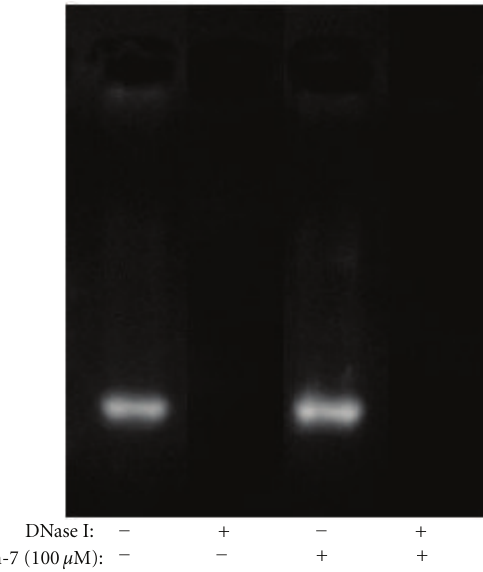
Figure 5: Representative image of agarose gel electrophoresis of the DNase assay. Bovine DNase I (4.0 U/mL) was incubated with 400 ng of pBR322 DNA in the presence of Van-7 (100 μ M) for 15 min at 37 ◦ C. Van-7 was unable to interfere with DNase activity. This experiment was repeated three times with similar